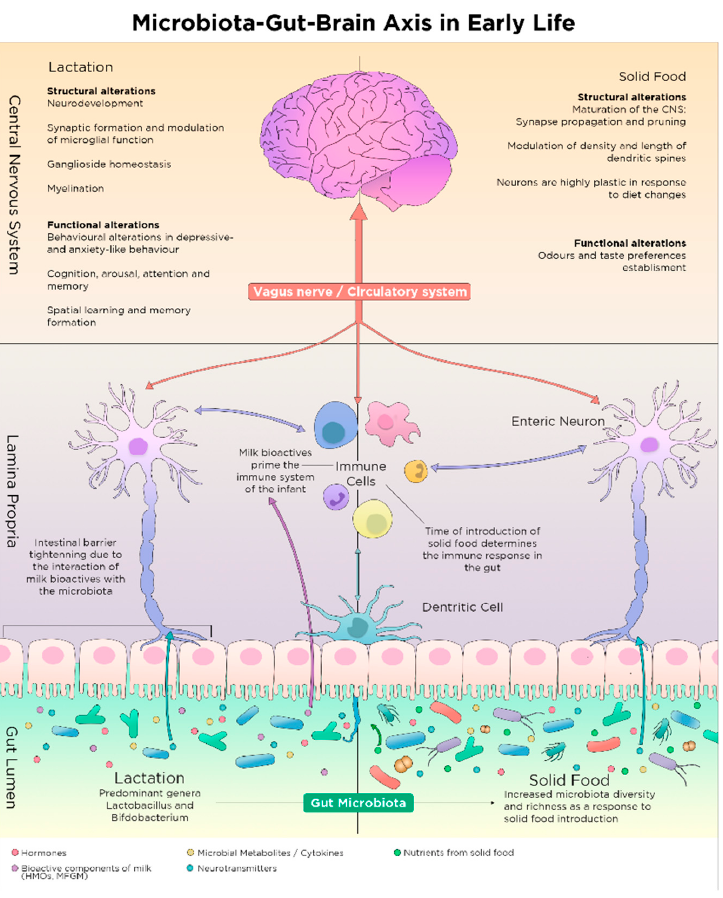
Figure 2. The effect of early life nutrition during lactation and solid food introduction on the gut microbiota development in the intestinal and the central nervous system; Microbes become